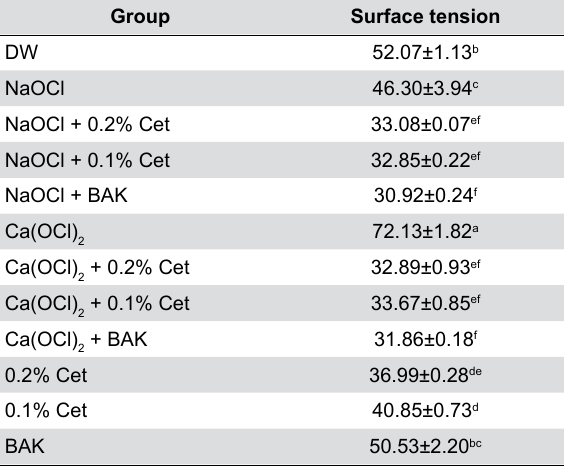
Table 3- Surface tension measurement in mN/m. (mean±SD)